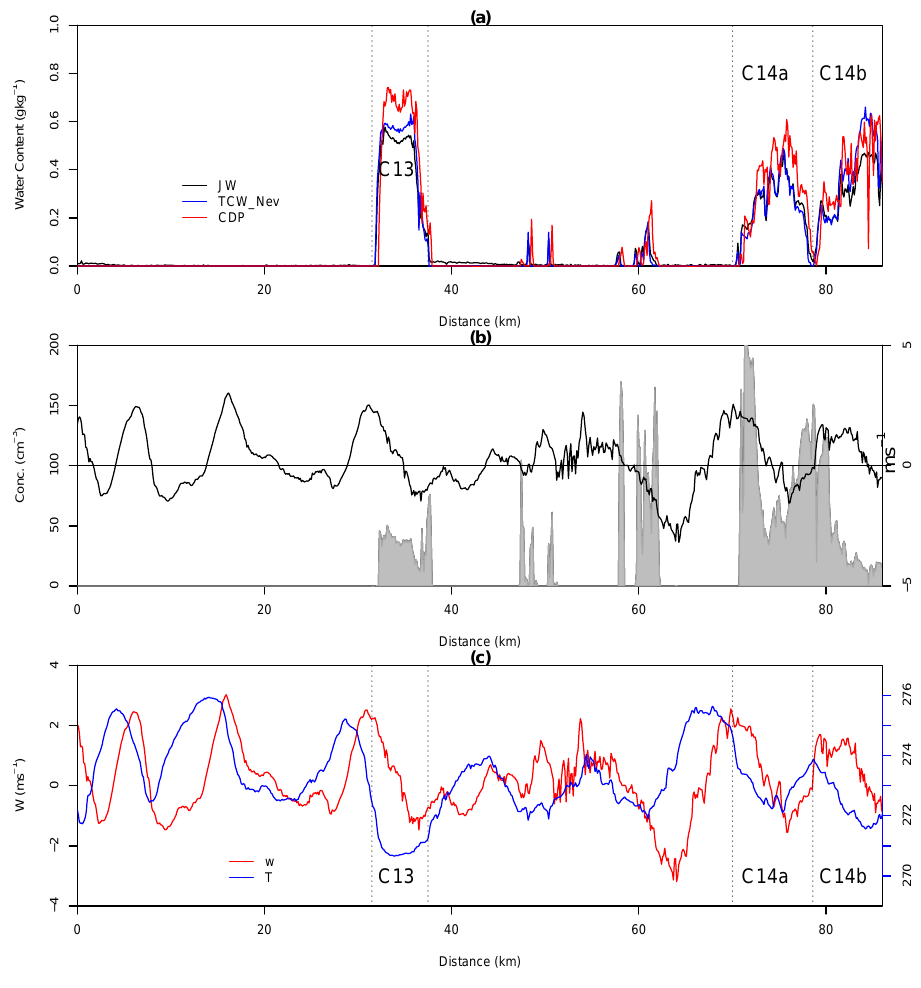
Fig. 8. As in Fig. 4 but for Run